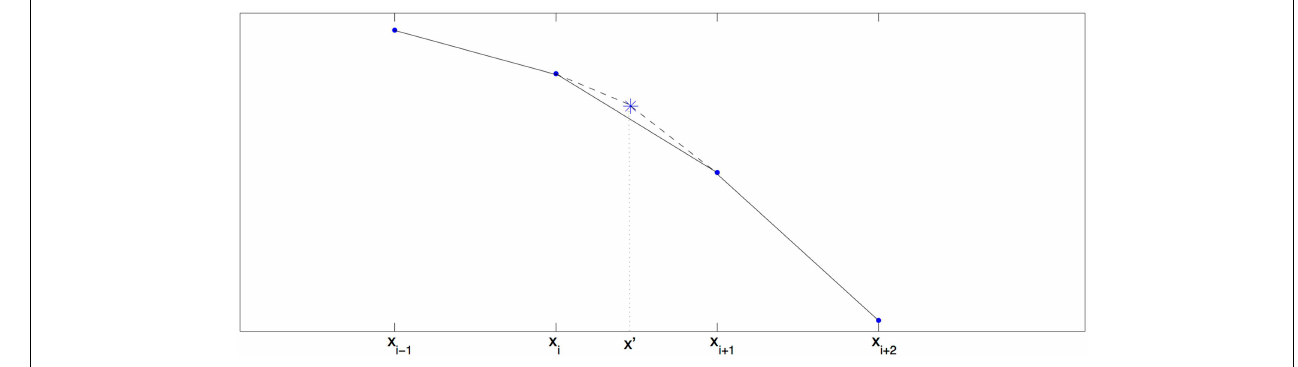
FIGURE 1 | Kink, plot of g against x .